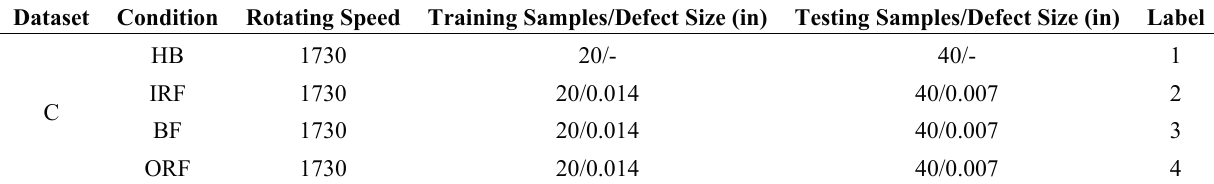
Table 2. Detailed specifics of REB fault dataset C.